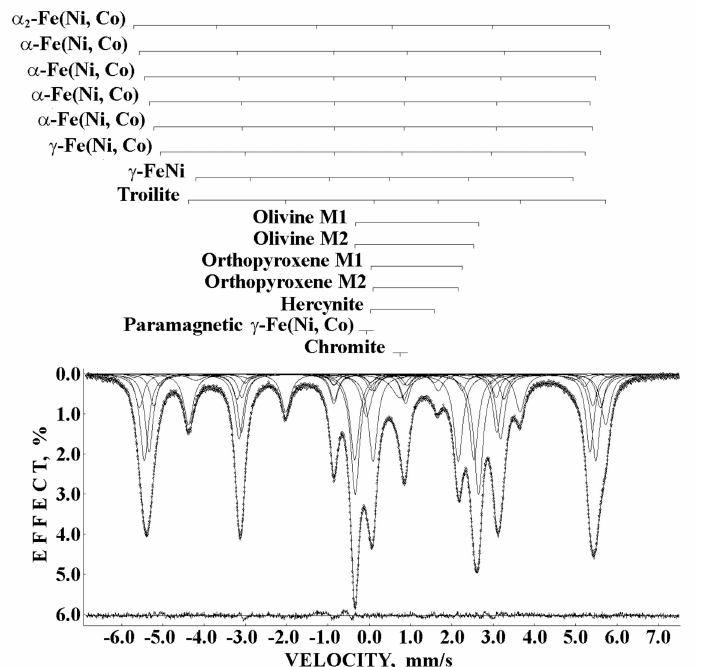
Figure 18. Room temperature Mössbauer spectrum of ordinary chondrite Annama H5. Spectral components are explained in the text. The differential spectrum is shown on the bottom. Adapted from Reference